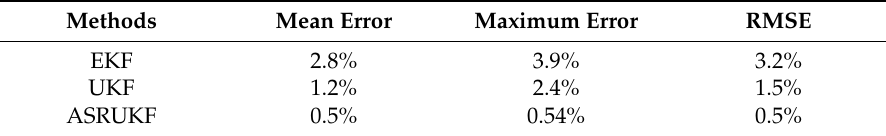
Figure 9. EKF, UKF, and ASRUKF SOC estimation errors in a constant-current random discharge test. Table 3. Comparison of SOC estimation error in a constant-current test.